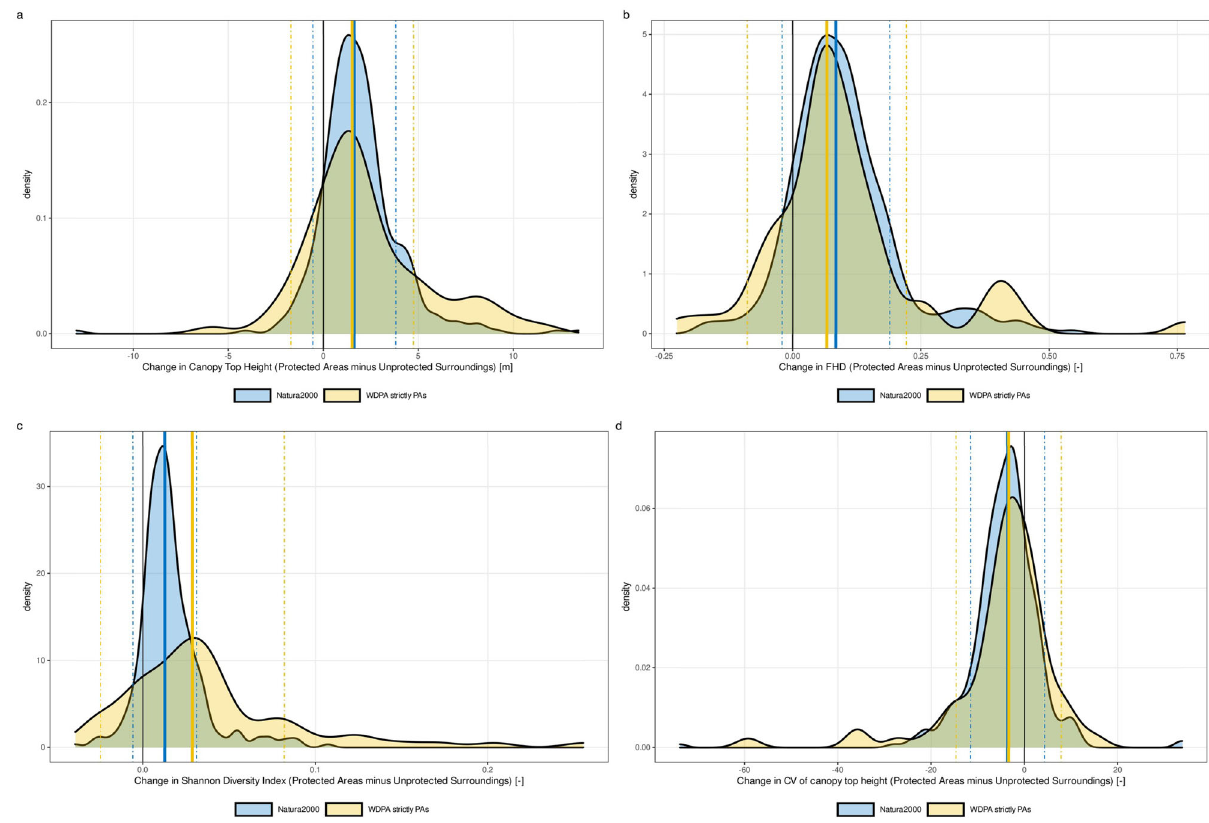
Fig. 2 Density plots of the differences between Protected Areas and Unprotected Surroundings. Density plots of the differences( a – d ) for Natura 2000 sites (blue fi lled) and strictly protected sites according to the World Database on Protected Areas (yellow fi lled - WDPA). The vertical solid line represents the mean value, while the vertical dot-dashed lines the standard deviation.